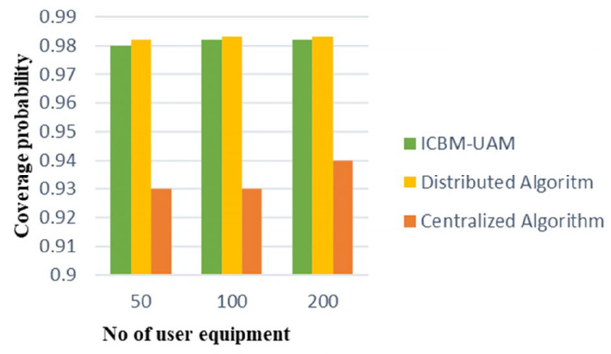
Figure 15. Coverage probability with obstacles.